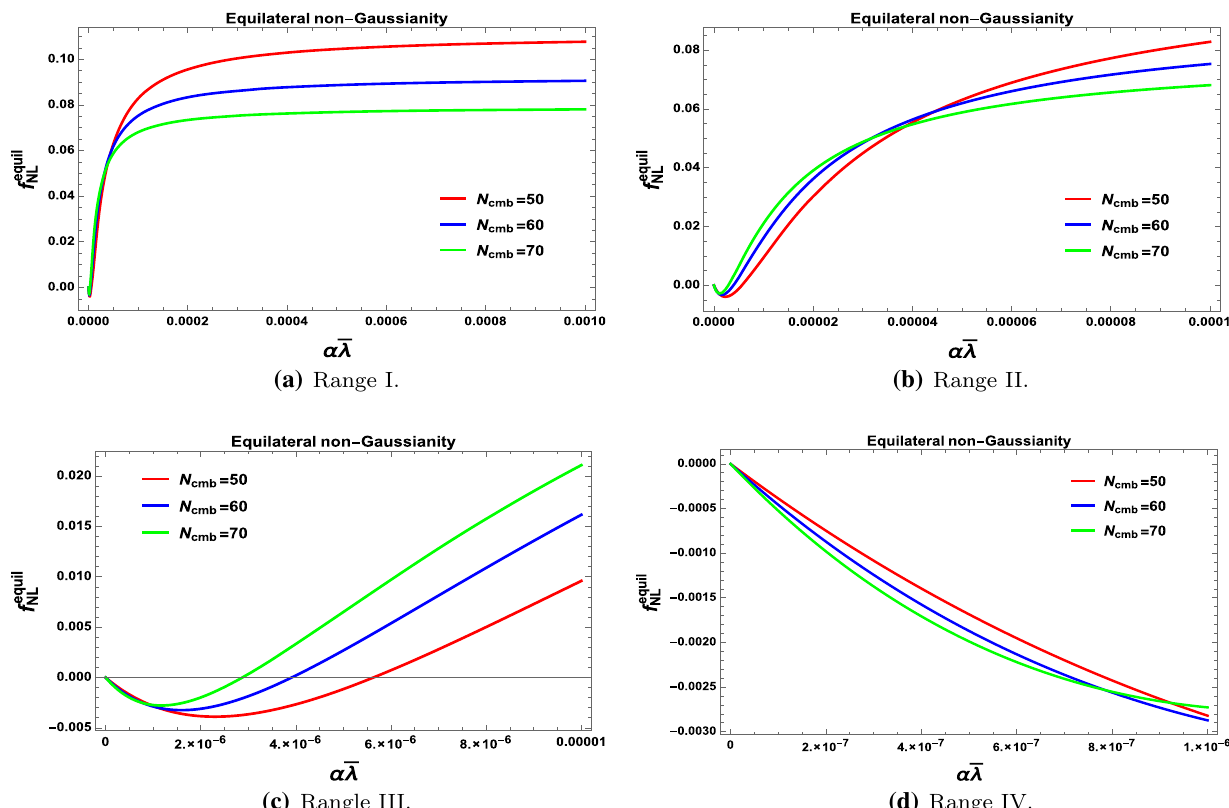
Fig. 12 Representative diagram for equilateral non-Gaussian three point amplitude vs. product of the parameters α ¯ λ in four different regions for = 50 ( red ), N = 60 ( blue ) and N = 70 ( green N cmb cmb cmb